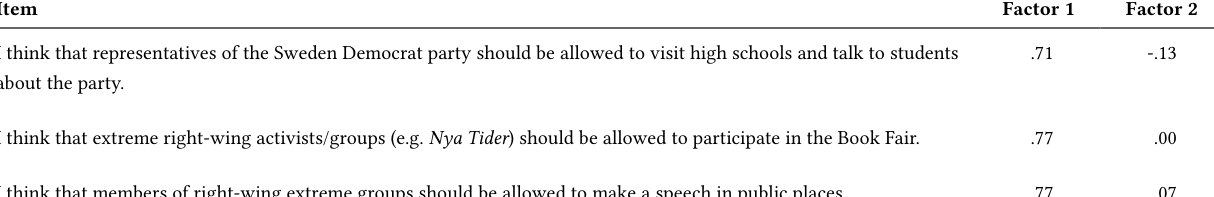
Factor 1 Factor